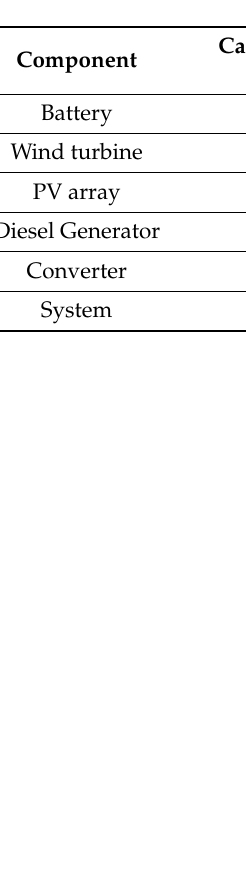
Figure 14. Yearly power output from PV array for PV-Wind-BSS-DG configuration. Figure 15. Yearly power output from wind turbine for PV-Wind-BSS-DG configuration.